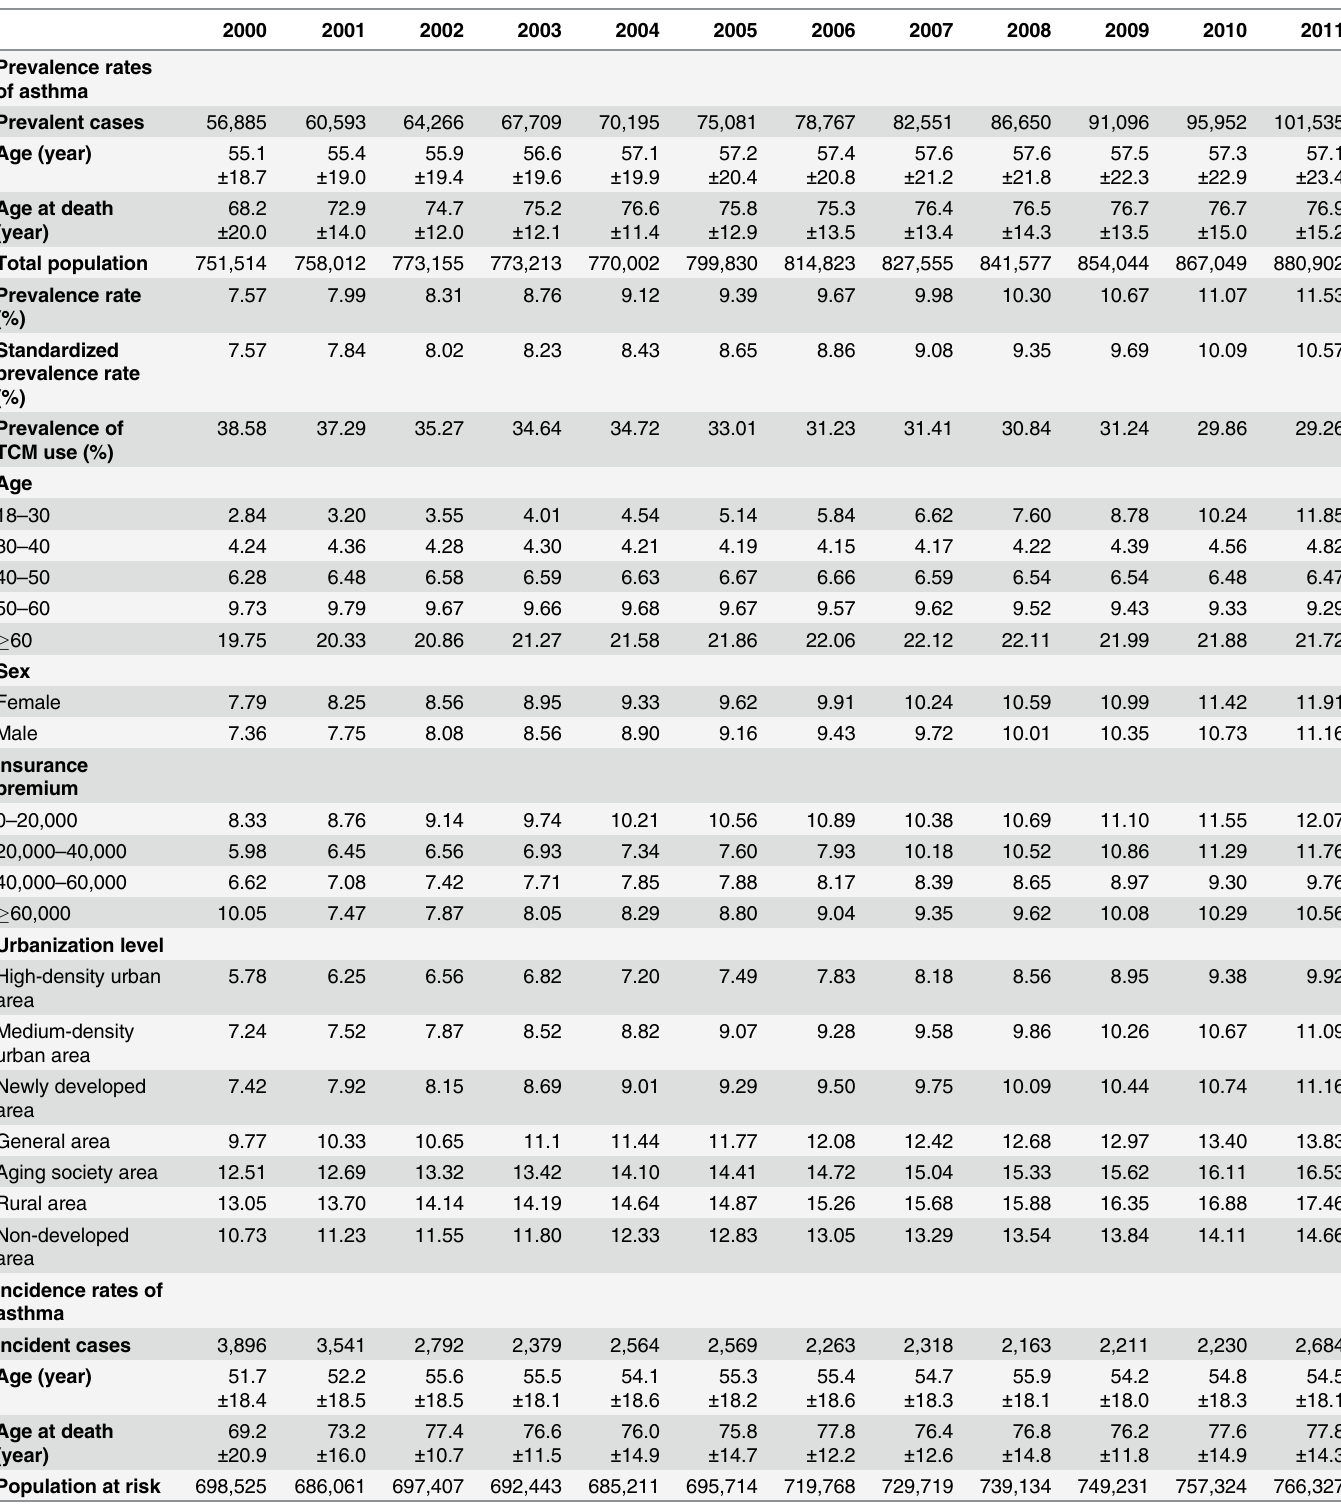
Table 1. Prevalence and incidence of asthma in